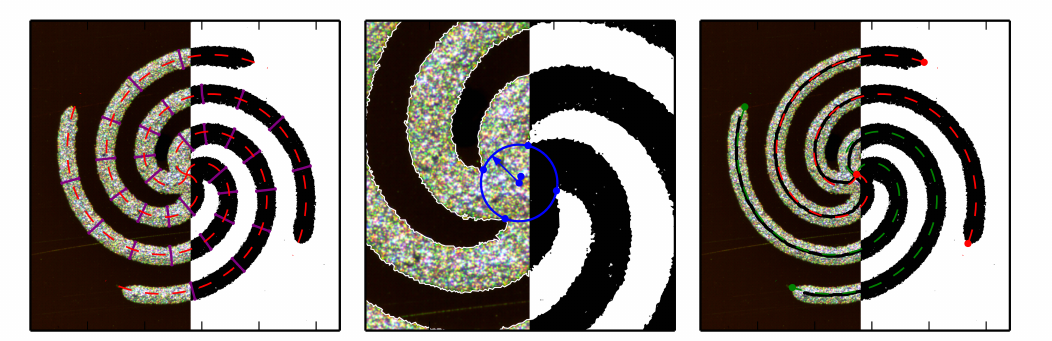
Figure A4. Image processing overlay on a single spiral. ( a ) Width measurement via purple bars perpendicular to the red print path, ( b ) center radius calculation from four blue minimum radius points and circular fit, ( c ) arm length calculation depicted by green starting point arms and red stopping point arms. Note: Images are flipped horizontally in analysis